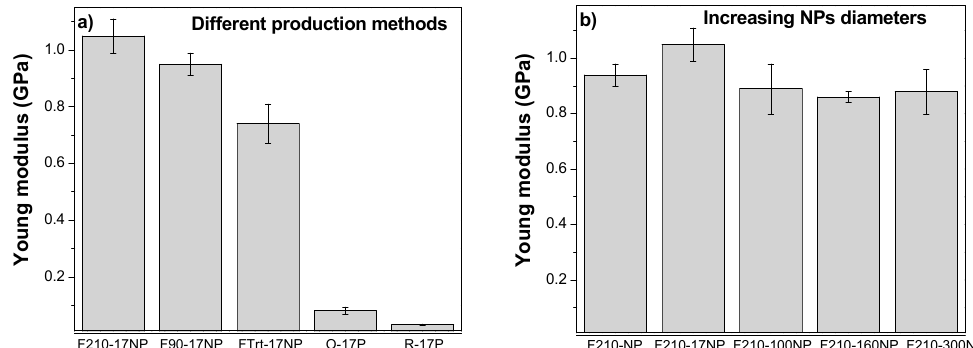
Figure 9. Young’s modulus of the SiNPs/PVDF nanocomposites varying ( a ) the processing method and ( b ) the average diameters of the SiNPs. The values are shown as mean ± SD.